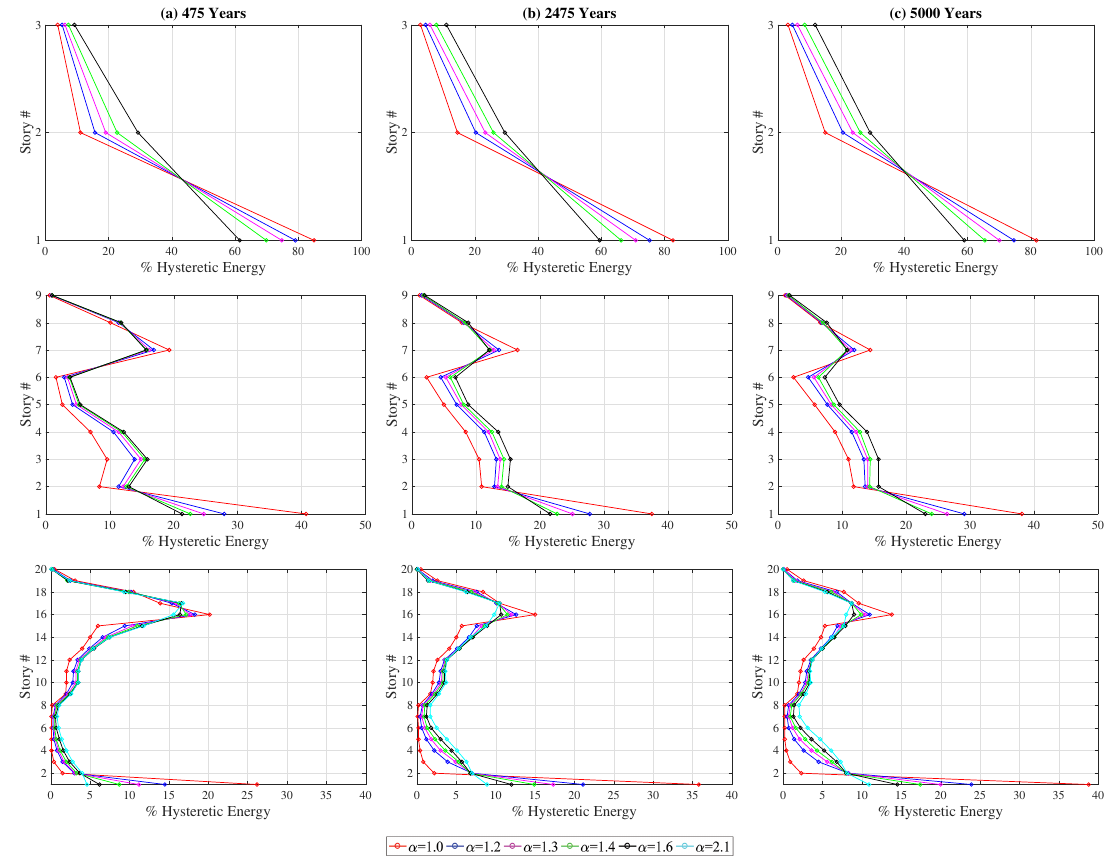
Figure 8. Variation of hysteretic energy demands over height with column-to-beam-strength ratio for ( a ) 10/50, ( b ) 2/50 sets ( c ) 1/50